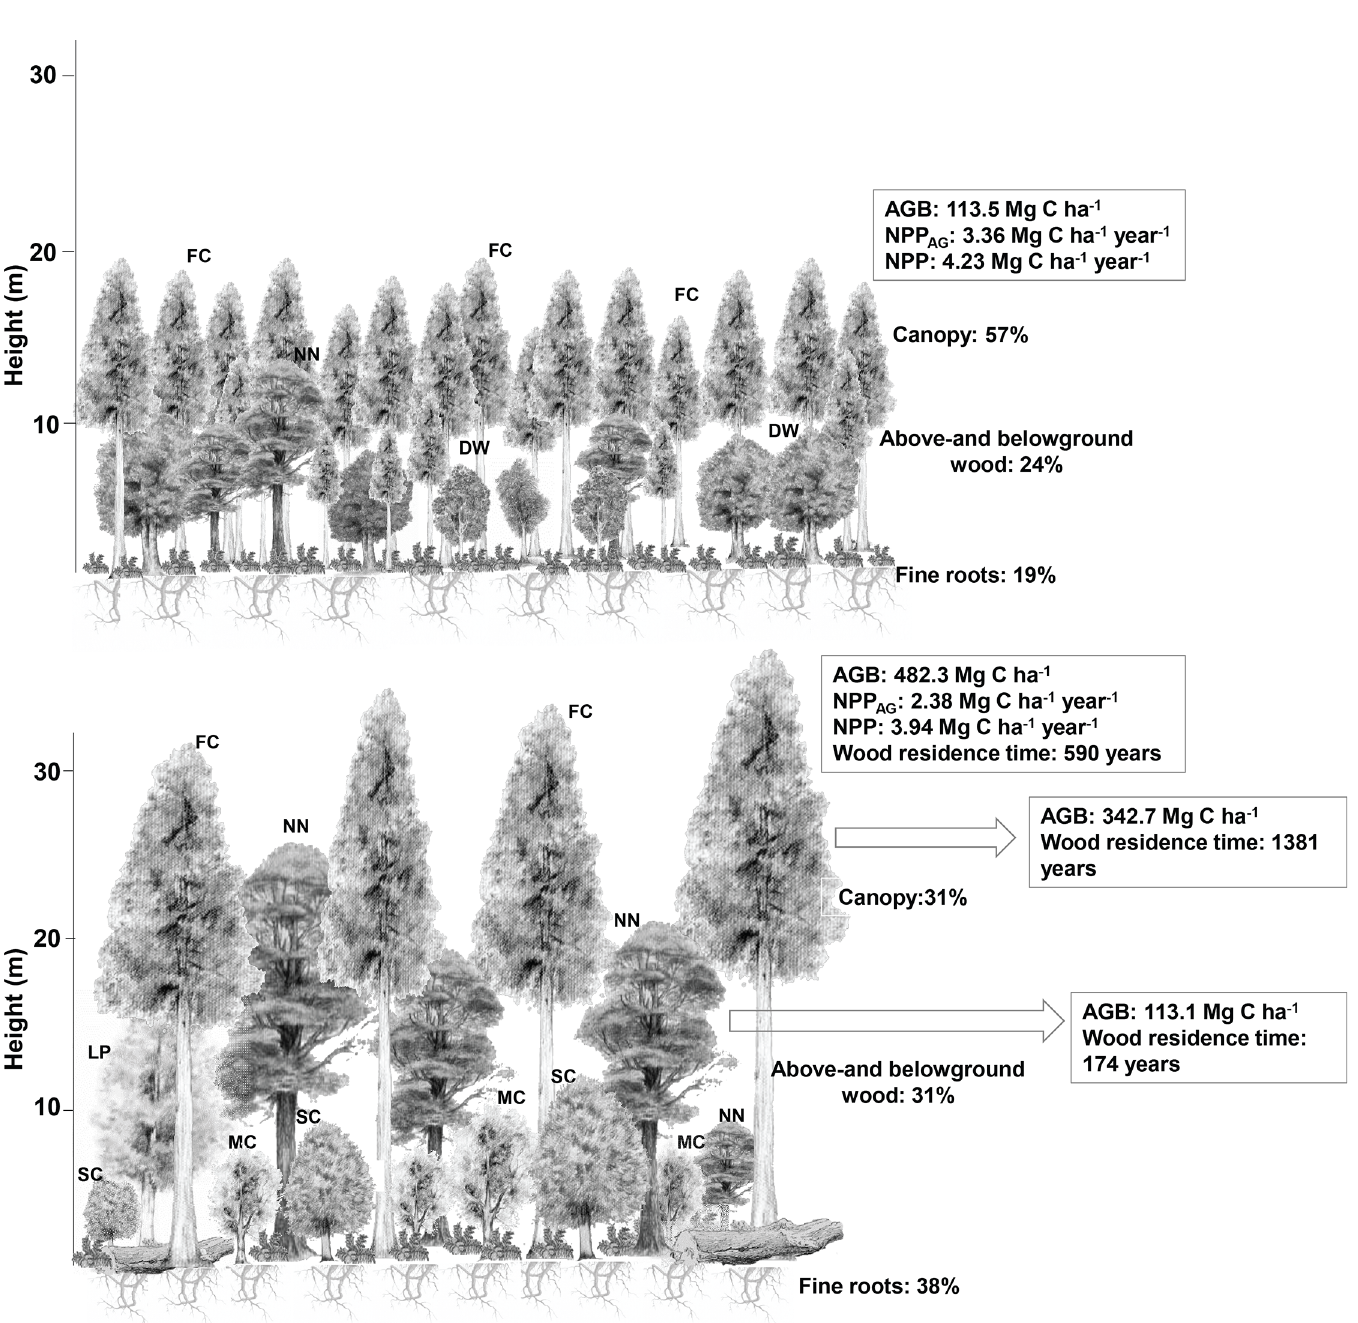
Fig 4. Forest structure and carbon dynamics in Alerce Costero and Andino. Diagram exemplifying the structure of the forest in the coastal (upper panel) and the Andean site (lower panel). The main species in each forest are identified, the mean values for each carbon cycle component from both plots and the productivity allocated to canopy, wood and fine roots (in %) are shown. Arrows indicate separated values for the Fitzroya stand only and the Nothofagus dominated subcanopy forests in AA. FC: Fitzroya cupressoides , NN: Nothofagus nitida , DW: Drimys winteri , LP: Laureliopsis philippiana , MC: Myrceugenia chrysocarpa , SC: Saxegothaea conspicua . AGB: aboveground biomass, NPP AG : aboveground productivity, NPP: total productivity.